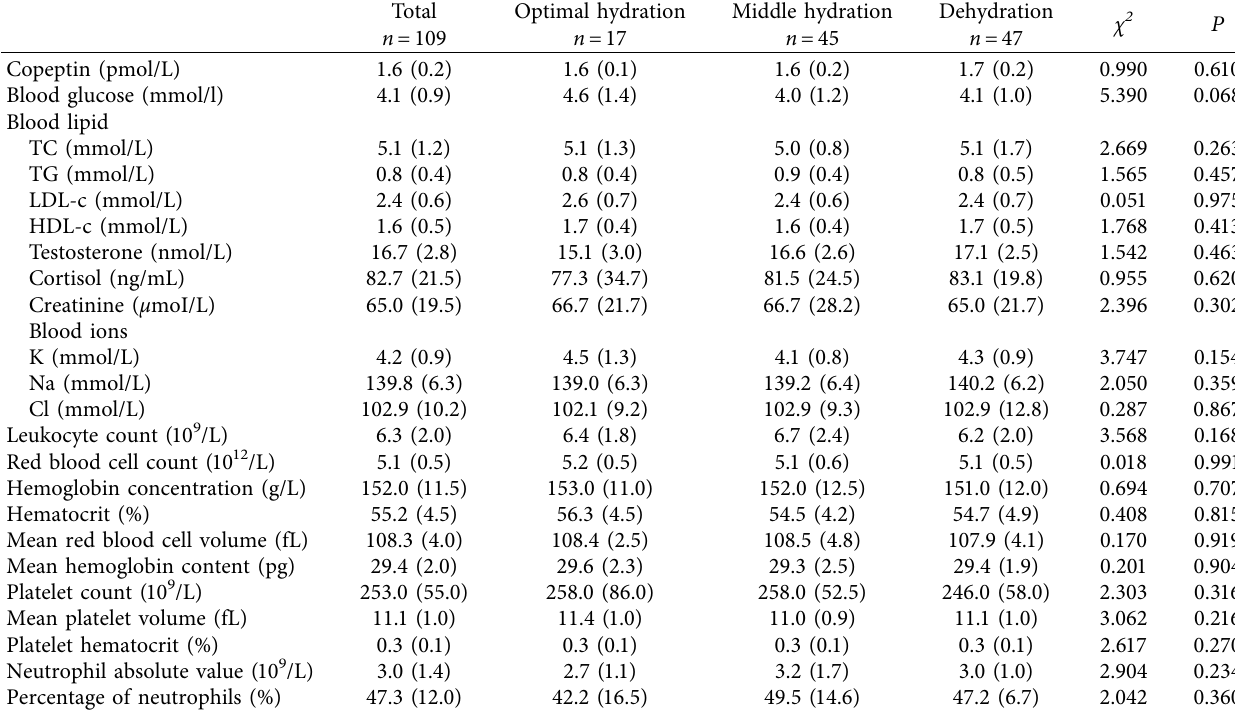
Table 5: Blood biomarkers of participants in different hydration